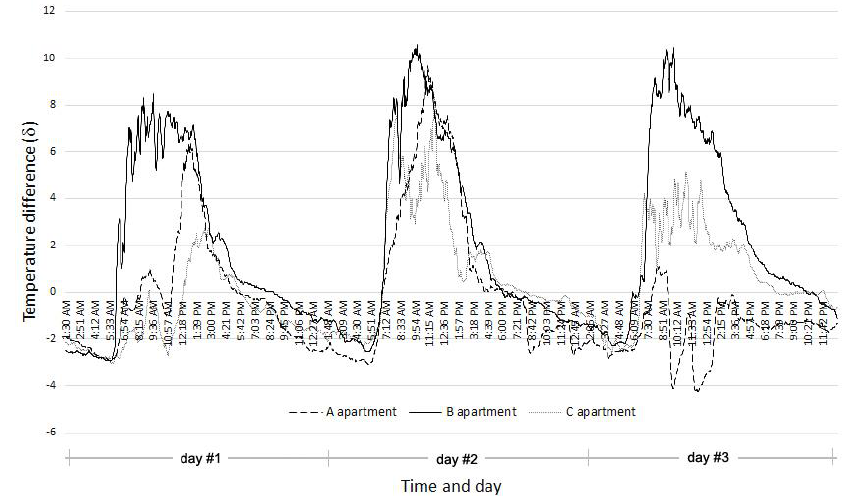
Fig. 15. Outdoors and indoors temperature difference (  ) of A, B, and C apartment buildings.